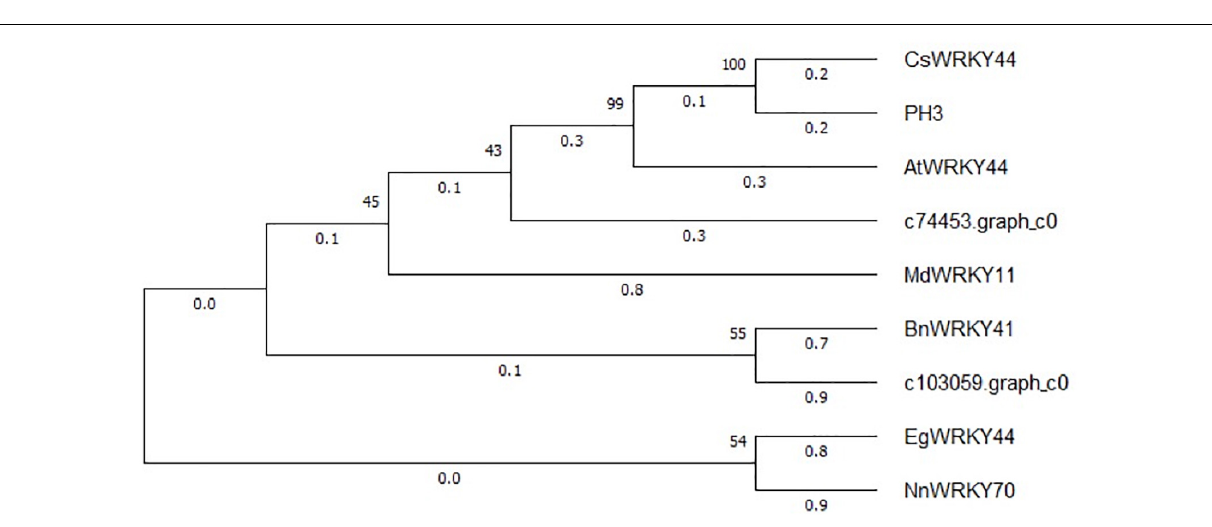
FIGURE 8 | Phylogenetic tree of two selected WRKY unigenes and WRKY TFs from other plant species. The sequences included Camellia sinensis CsWRKY44 (MG298960.1), Petunia hybrida PH3 (AMR43368.1), Arabidopsis thaliana AtWRKY44 (NM_129282.4), Malus domestica MdWRKY11 (HM122714.1), Brassica napus BnWRKY41 (XM_013831080.2), Elaeis guineensis EgWRKY44 (XM_029264803.1), and Nelumbo nucifera NnWRKY70